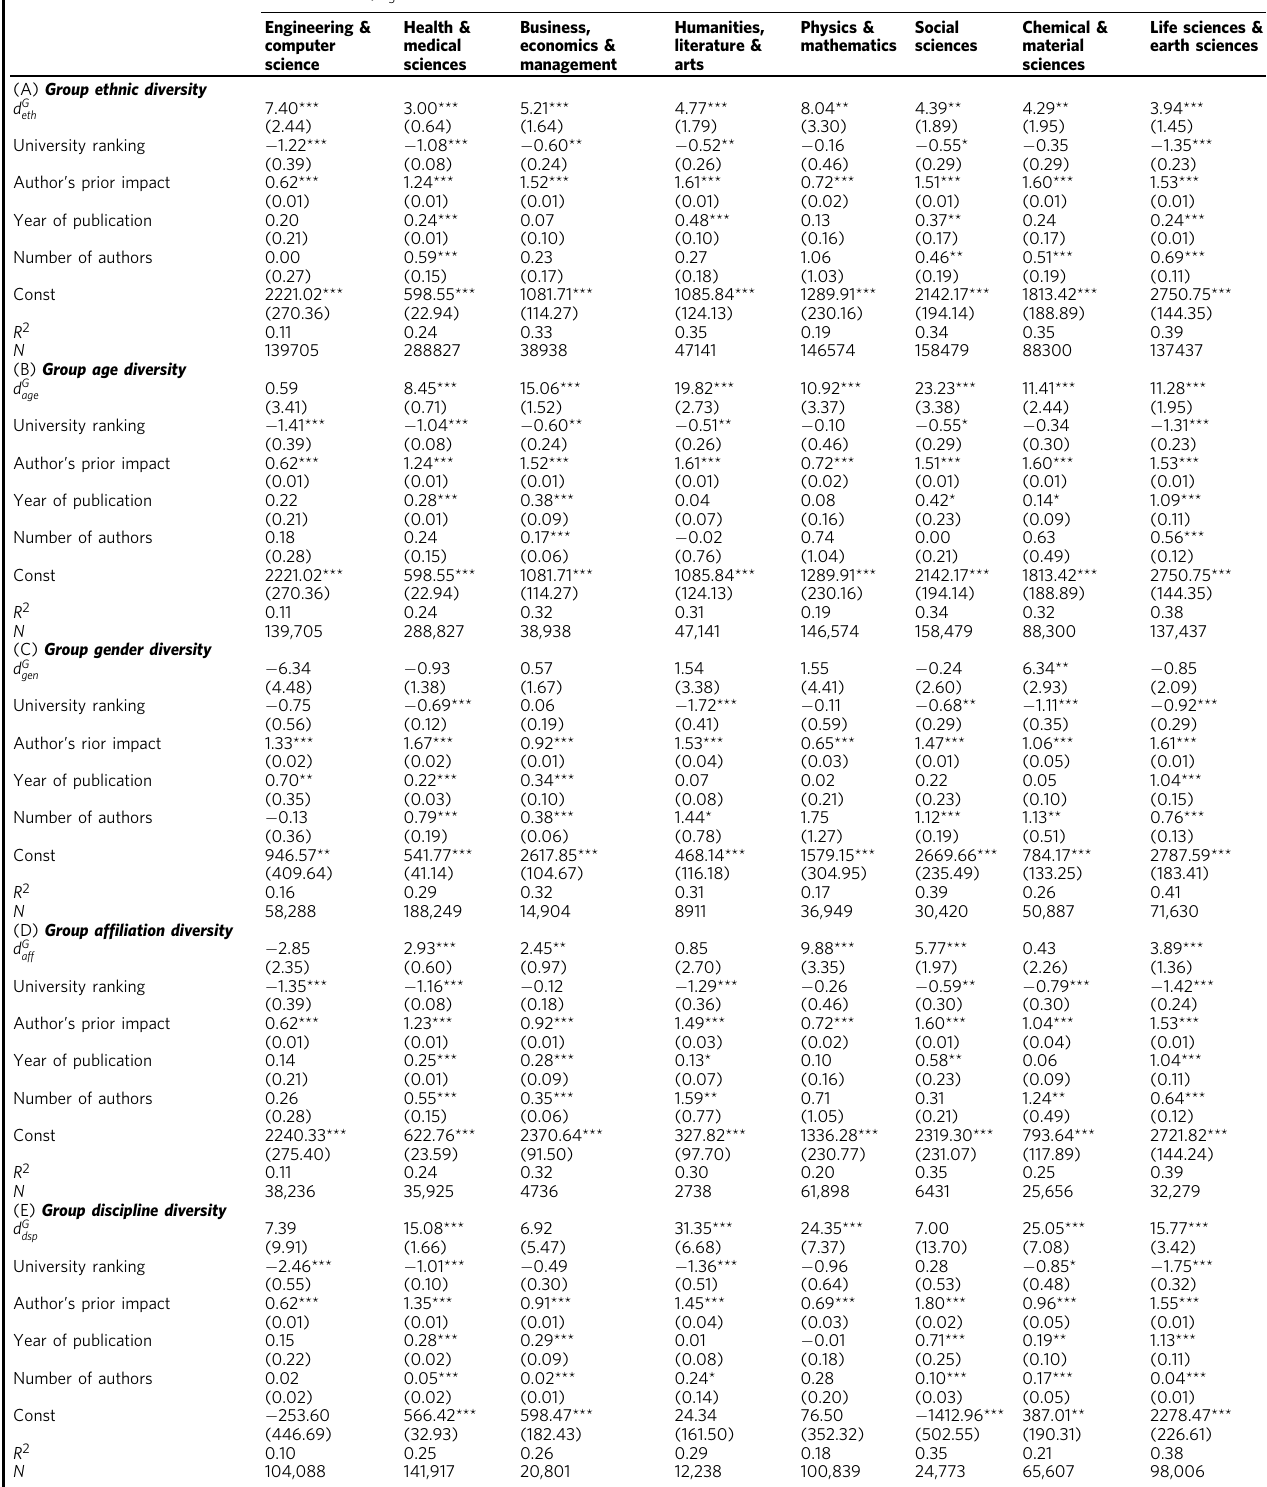
Table 1 Regression analyses of diversity classes on academic